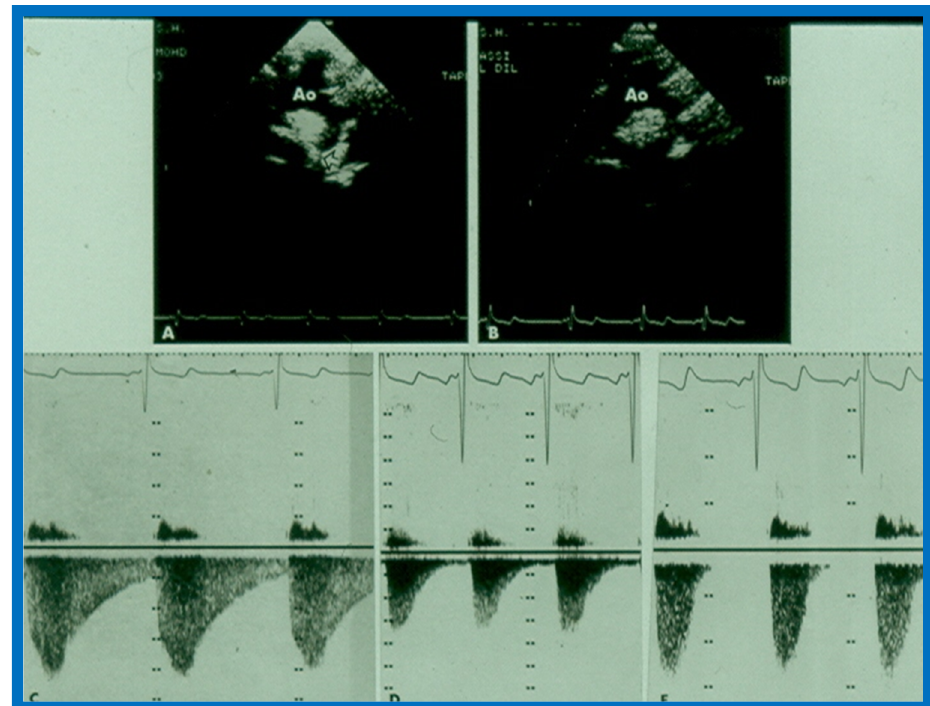
Figure 54. ( A , B ) Two-dimensional (2D) echo images prior to ( A ) and following ( B ) balloon angioplasty of aortic coarctation show improvement in ( B ). ( C – E ) Continuous wave Doppler flow velocity recordings from suprasternal notch directing the Doppler signal towards the descending aorta prior to ( C ) and immediately following ( D ) balloon angioplasty of aortic coarctation and at six months after angioplasty ( E ) are shown. Note the reduction of peak Doppler flow velocity from ( C ) to ( D ) with further fall in ( E ). Also note that the diastolic flow is seen throughout the entire diastole (pandiastolic) prior to angioplasty ( C ), and is seen only is early diastole immediately after angioplasty ( D ) and at six-month follow-up ( E ), there was no diastolic flow at all. Reproduced from Rao P.S. [17].